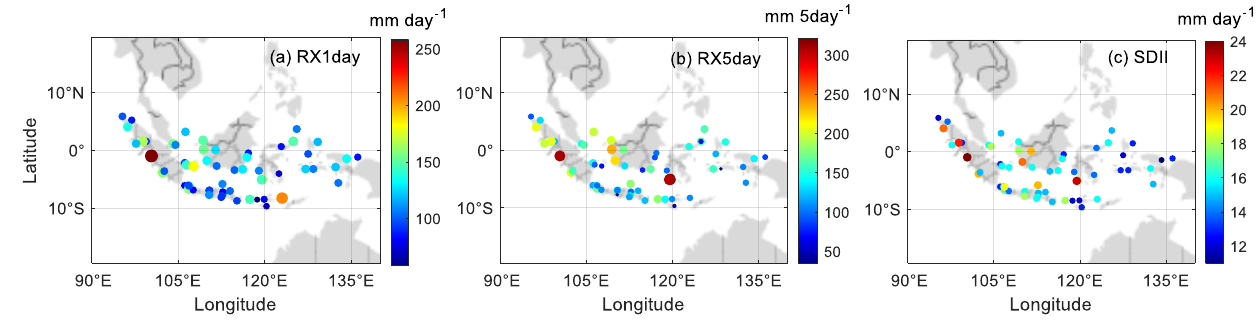
Figure 9. The mean value of precipitation-intensity-based indices including RX1day ( a ), RX5day ( b ) and SDII ( c ), for 63 of BMKG stations in the IMC during 2016 to